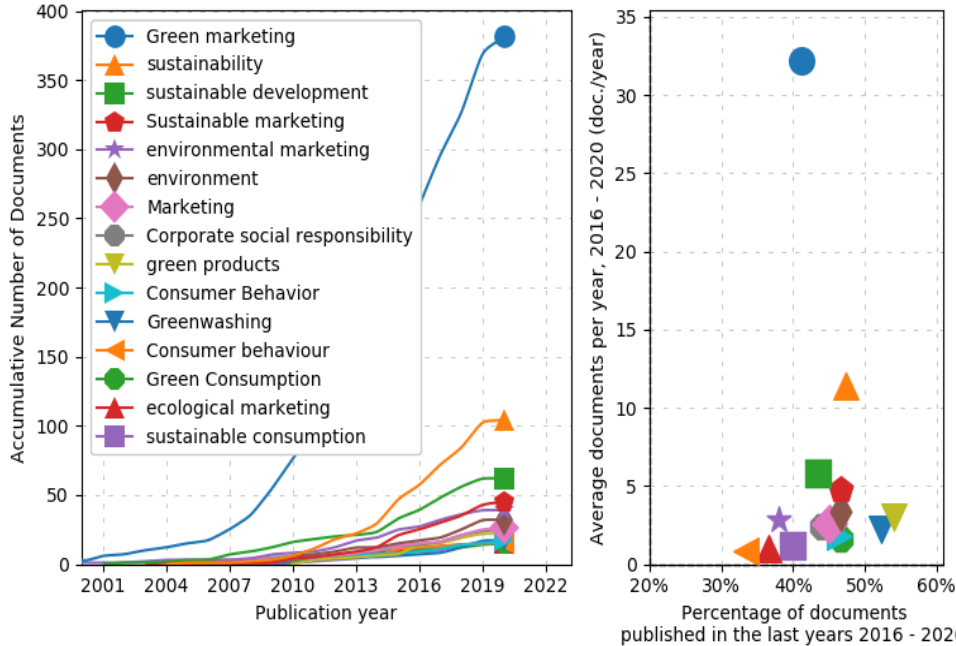
Figure 7. Author keyword analysis between the years 2001–2020.